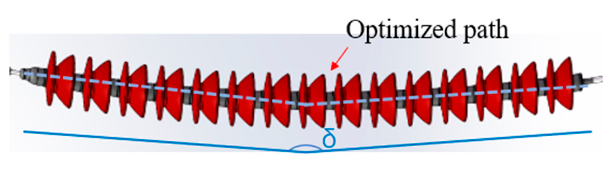
Figure 9. Optimized detection path.